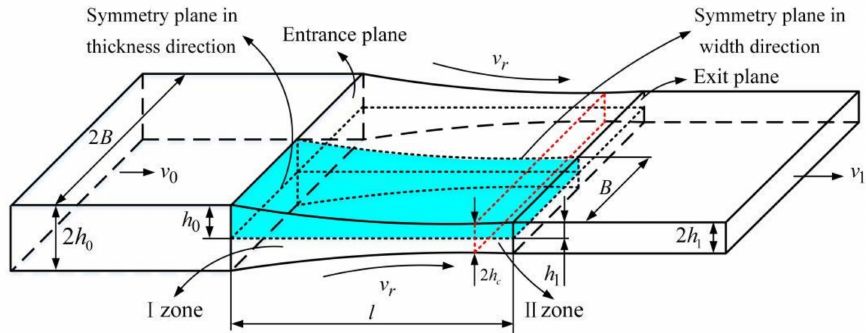
Figure 2. Definition sketch of the bite zone.